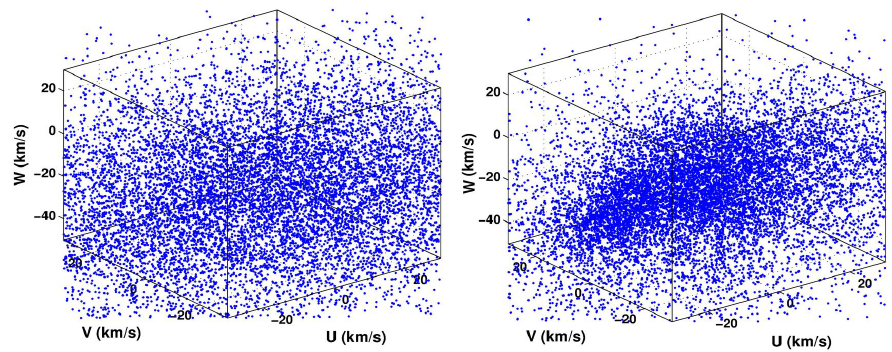
Fig. 2. Distribution of representative points in the velocity space according to the Geneva-Copenhagen Survey data (left-hand panel) and random Schwarzschild distribu- tion with the same dispersions (right-hand